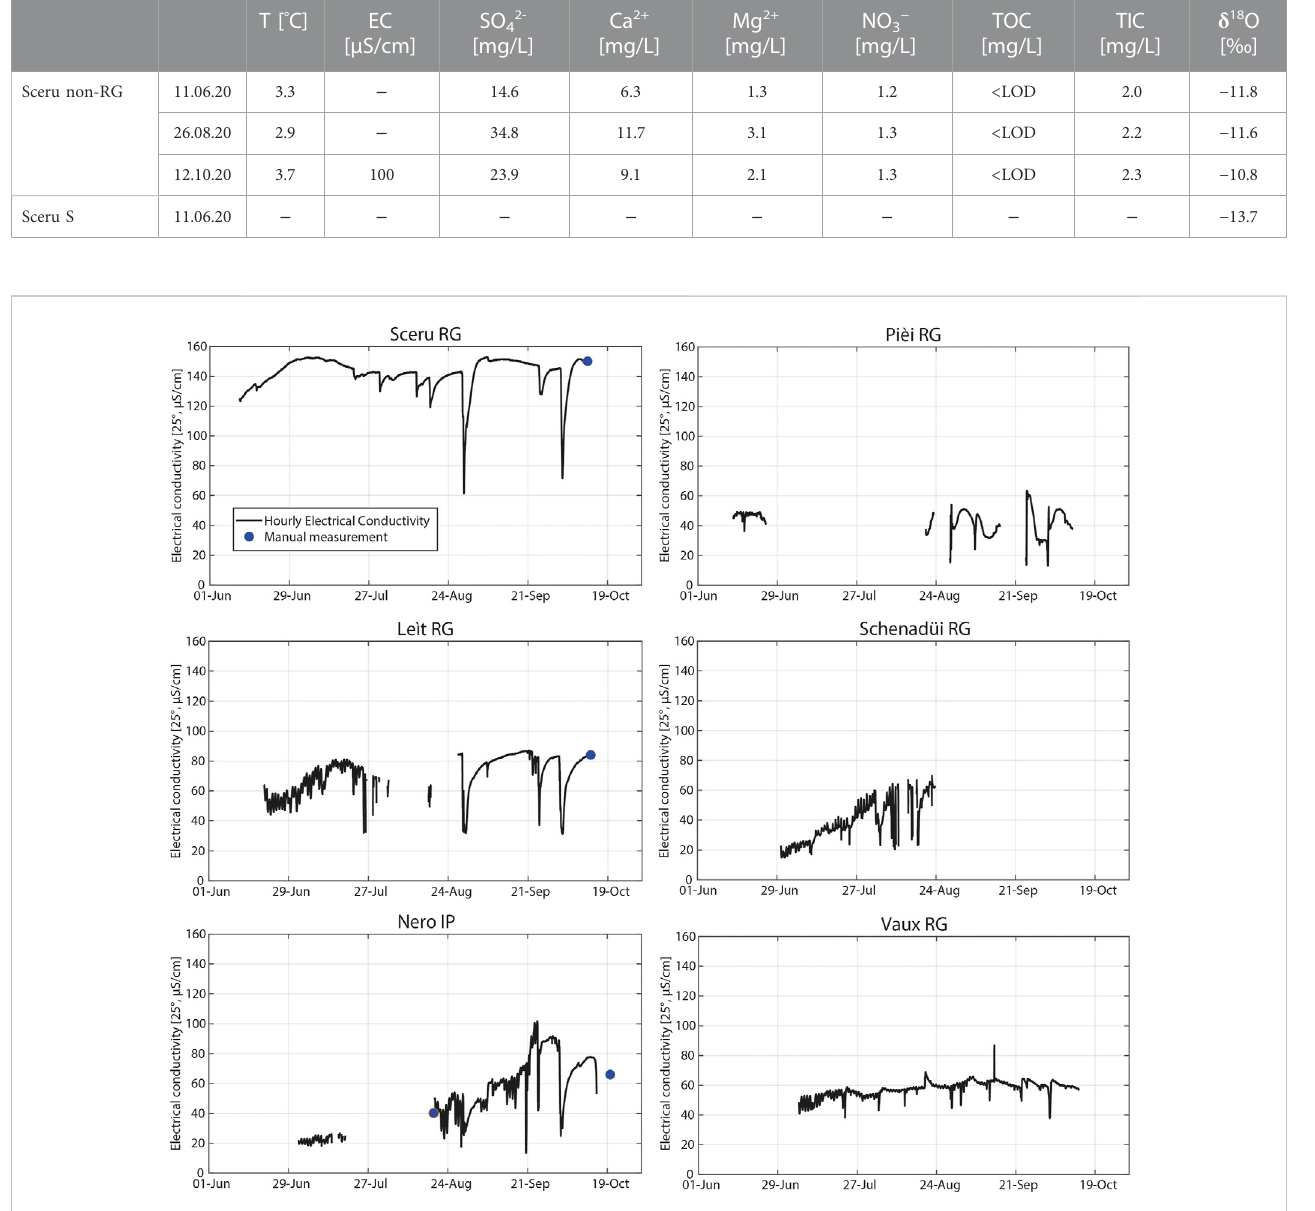
FIGURE 3 Hourlymonitoring oftheelectricalconductivity inRGsources.Manualmeasurementsoftheelectrical conductivity throughadigital conductivitysensor are also